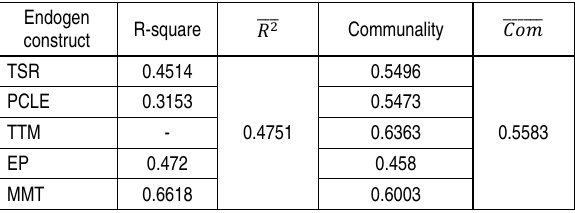
Table 4. R 2 value, average R 2 value, communality and average